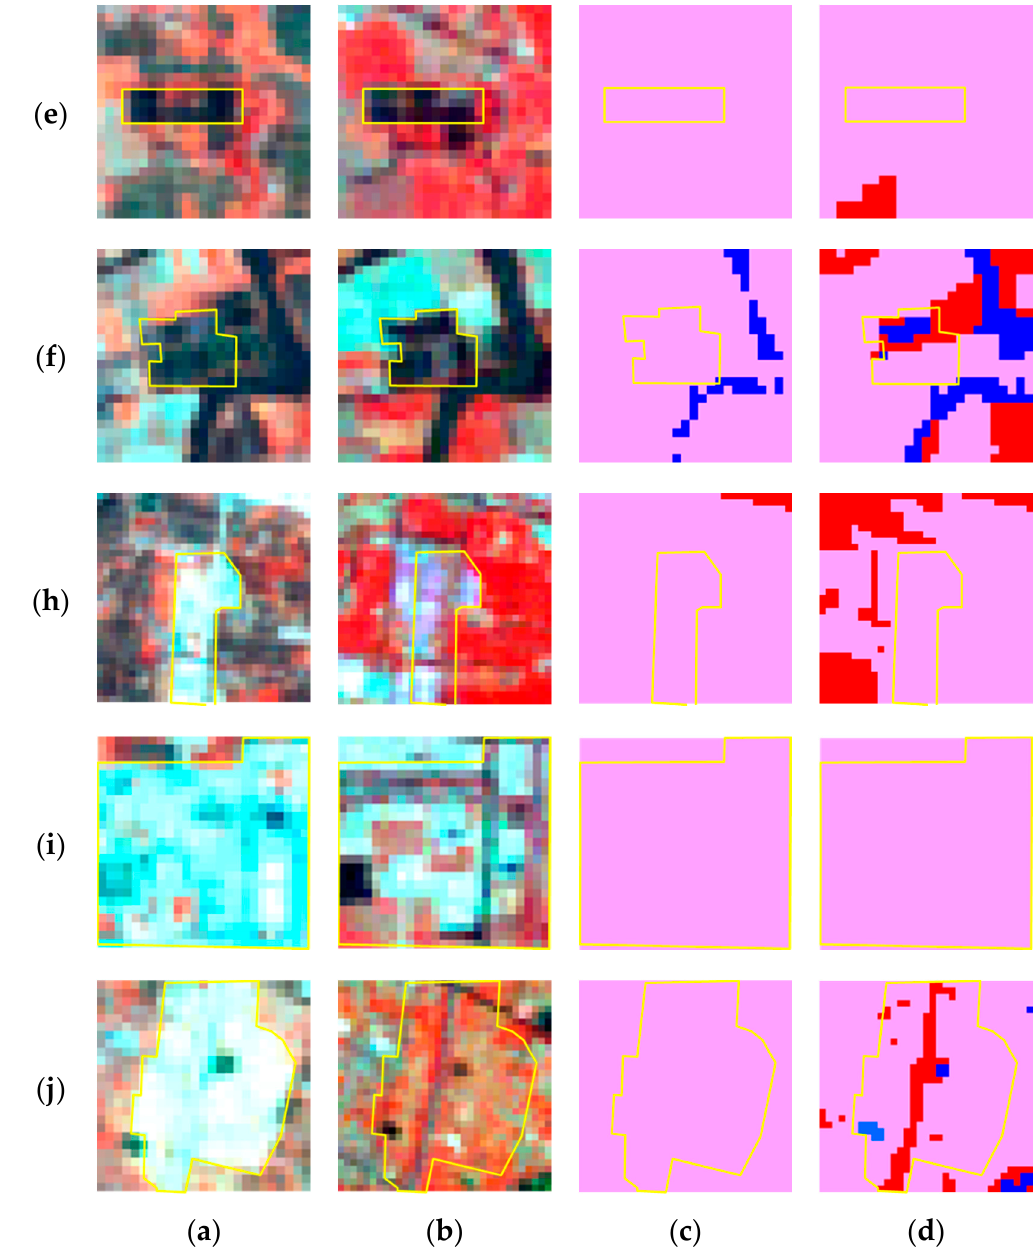
Figure 12. Influence of the base map on the updating results: images from ( a ) 2000 and ( b ) 2011. ( c ) Classification map from GlobeLand30 2000. ( d ) Classification results for 2011 obtained using the proposed ECVA_OB+SVM method.